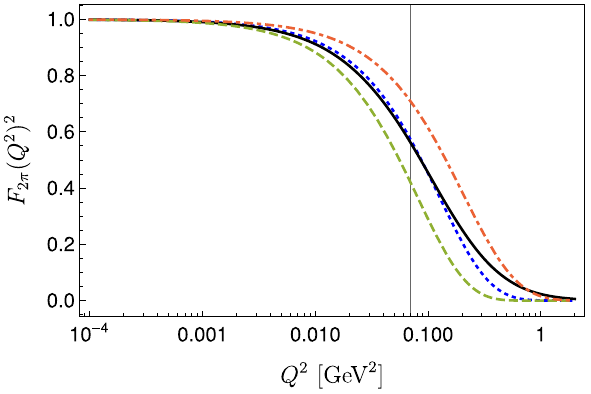
Fig. 3 Same of Fig. 2 from Ref. [58]. Full line the lattice calculation. Dot-dashed line calculation for the model of Ref. [57]. Dotted line for the model of Ref. [26] and dashed line for that of Ref.